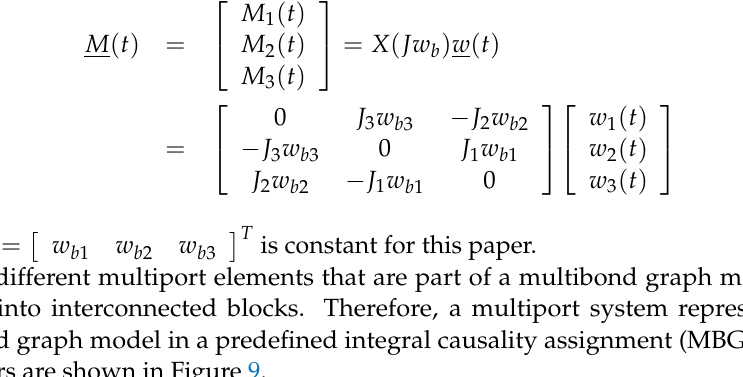
Fig. 6 . Eulerian junction